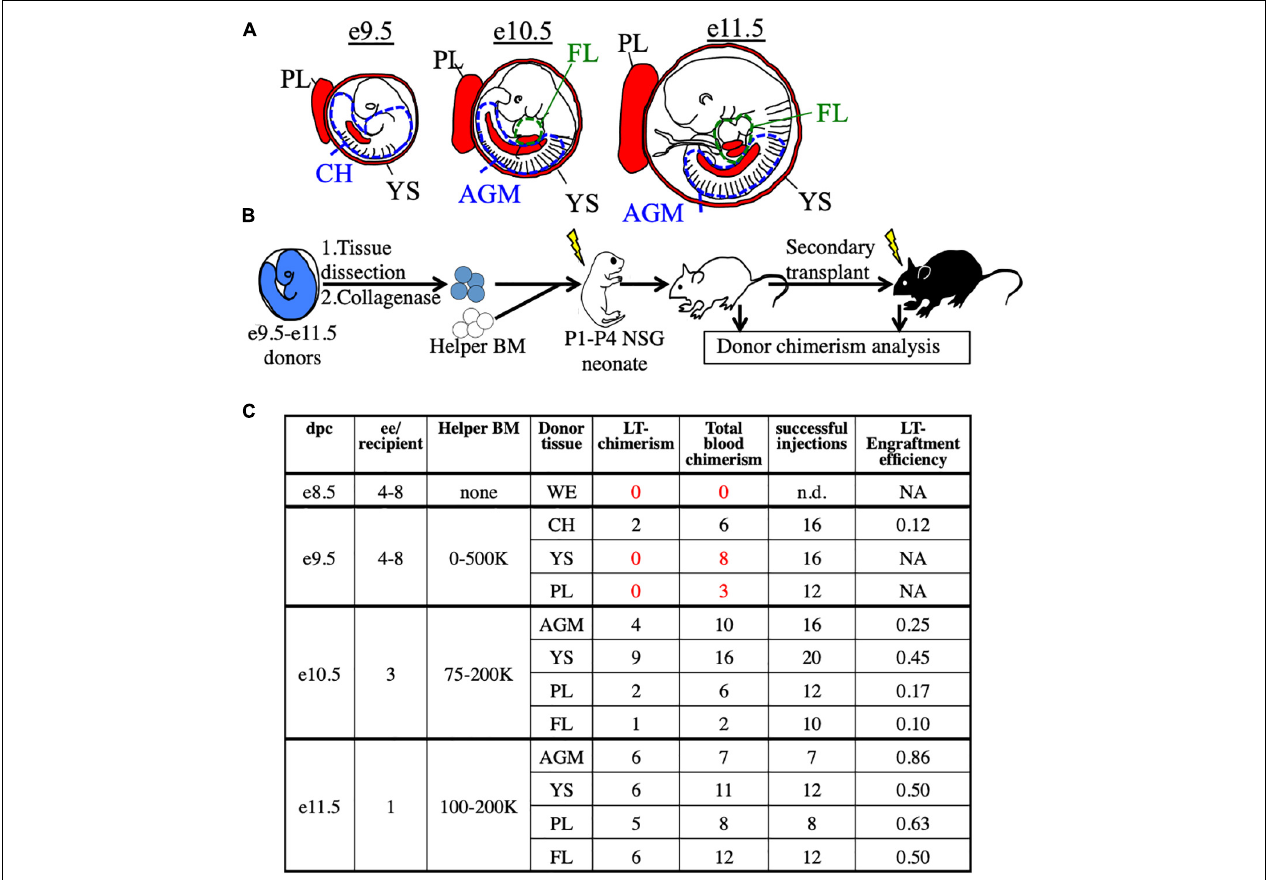
FIGURE 1 | Utilization of the NSG neonatal transplant system to reveal pre-HSCs in e9.5–11.5 embryos. (A) Schematic representation of hematopoietic tissues (red) harvested from e9.5, e10.5, and e11.5 embryos. YS, yolk sac; PL, placenta; CH, caudal half; AGM, aorta-gonad-mesonephros; FL, fetal liver. Dissection sites of the CH/AGM and FL are shown in blue and green dashed lines, respectively. (B) Schematic representation of the neonatal transplant system. Harvested tissues from e9.5–11.5 donor CFP+ embryos are dissected, dissociated, and combined with CFP- adult helper BM. Donor cells are administered intravenously (i.v.) into irradiatated neonatal NSG recipients of 1–4 days of age (P1-P4). Recipients are bled for donor chimerism analysis at 4 week intervals and are then sacrificed for BM analysis and secondary transplants. (C) Compilation of whole-tissue transplants from e8.5–11.5 embryos. Number of successful tissue-specific long-term engraftment (“LT-chimerism”) is determined by the presence of ≥ 1% embryo donor granulocyte chimerism (at the last bleed) and HSPC (hematopoietic stem/progenitor cell) chimerism in the BM. “Total blood chimerism” refers to the number of recipients with ≥ 1% embryo chimerism in total CD45+ compartment of blood. “Successful injection” is defined as engraftment of either embryo or helper adult BM donors. “Engraftment efficiency” is determined by # of successful embryo engraftment/total successful injections. dpc, days post conception; ee, embryo equivalent; WE, whole